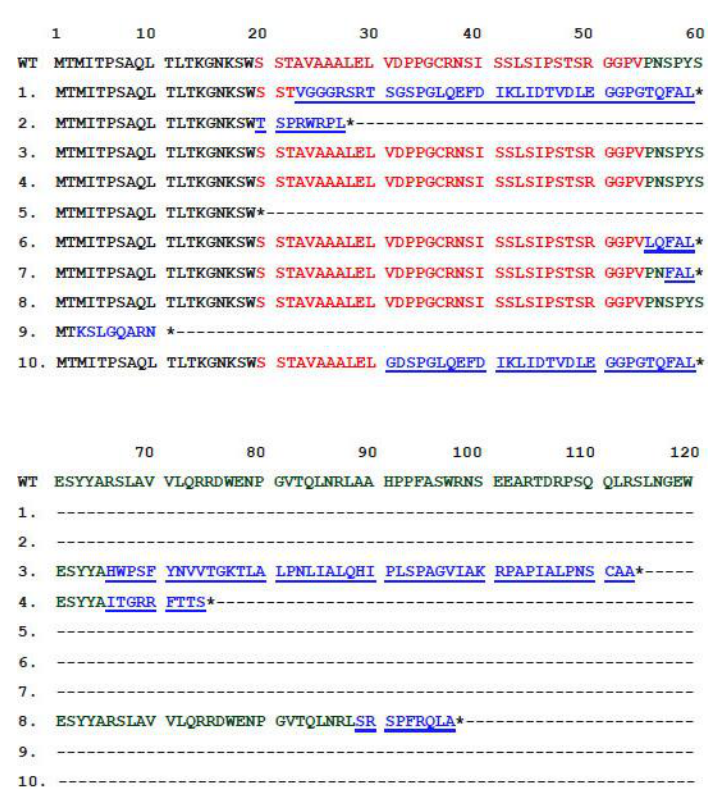
Figure 6. lac Z α-peptide amino acid sequence aliment of one wild-type and 10 mutated clones. The amino acid sequences encoded by multiple cloning sites are labeled in red; the sequences encoded by lac Zα are labeled in green; and the mutation-caused reading frame shifts are labeled in blue. The * indicates the translation termination by the stop codon.